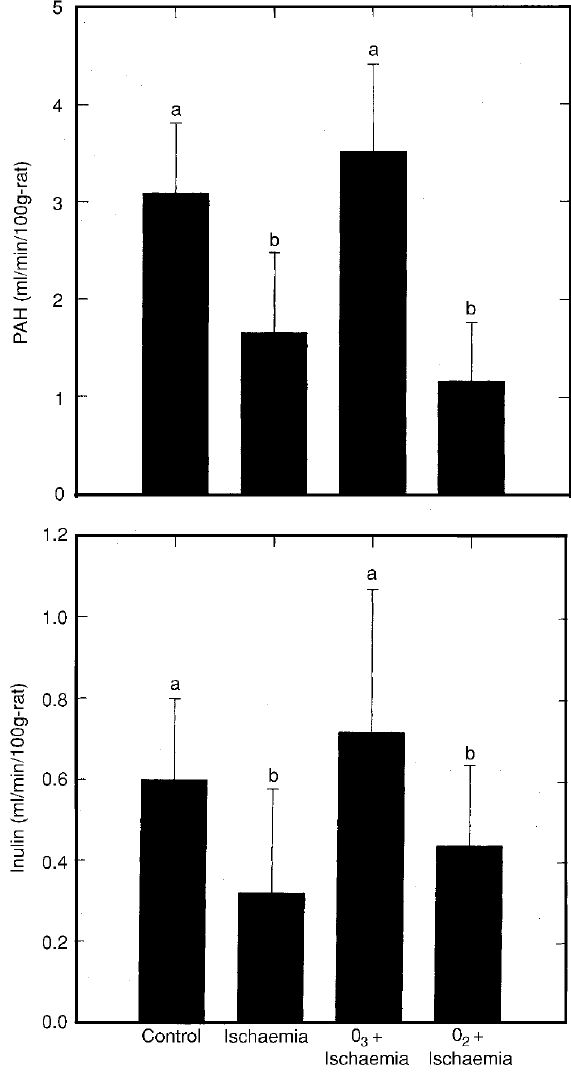
FIG. 1. Plasmatic clearances of p-amino-hippurate (PAH) and inulin in the different groups of treatment. Values represent mean ± SE. Different letters indicate P < 0.05.